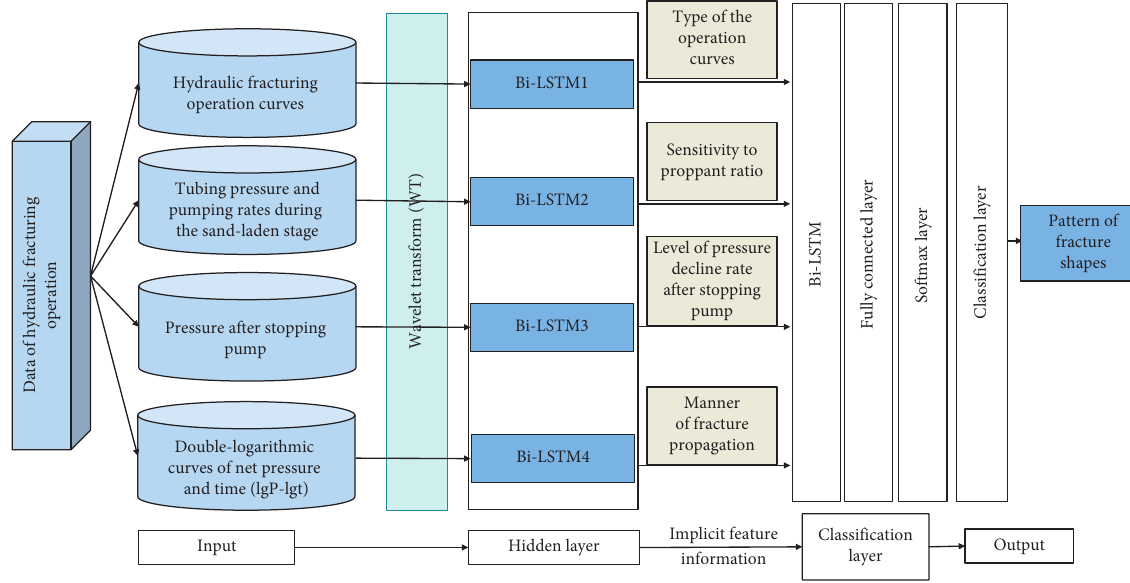
Figure 3: The framework of the presented